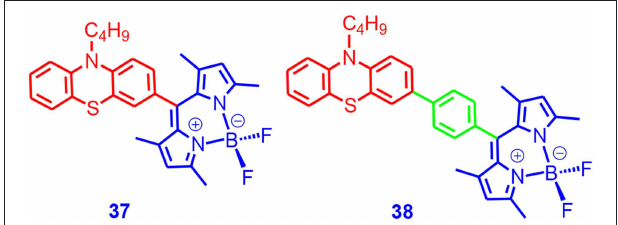
FIGURE 12 | Bodipy derivative with phenothiazine (PTZ) moiety as electron